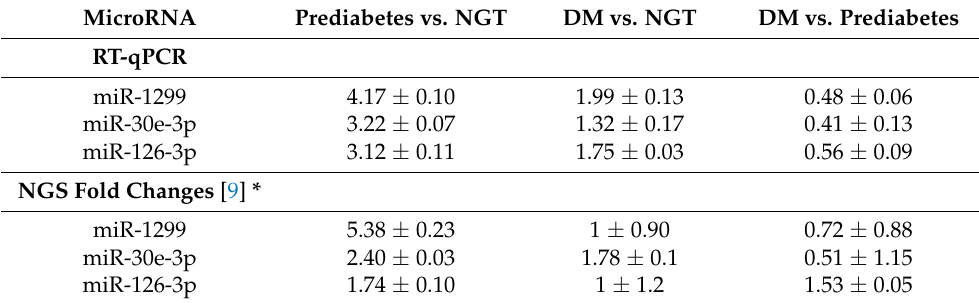
Table 2. Fold change analysis, 2 − ∆∆ Ct between the glucose tolerance